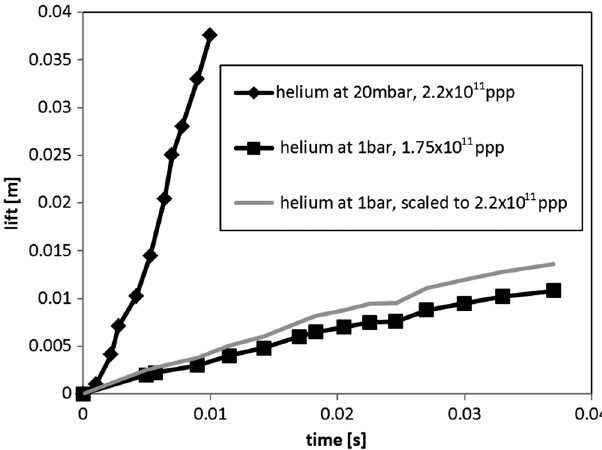
FIG. 23. Response of a polydisperse sub- 250 μ m crystalline tungsten powder sample in helium at 1 bar and at 20